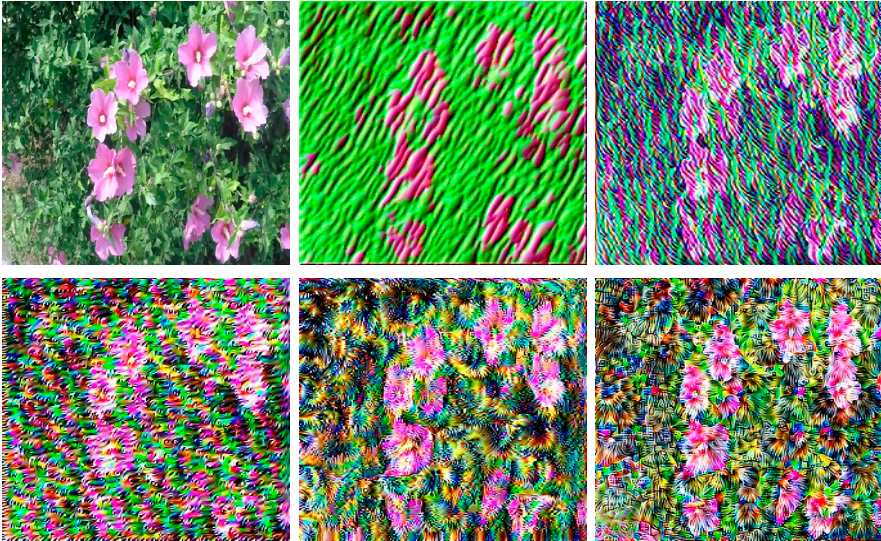
Figure 7. Feature response of layers in CNN. First row is original image, conv_2 layer and conv_4 layer. Second row is conv_6 layer, conv_9 layer and conv_12 layer.